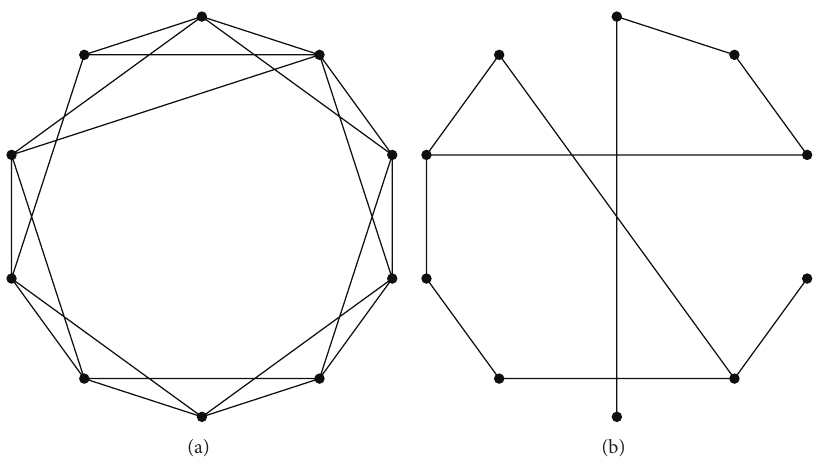
Figure 7: WS Small-Worlds with 10 nodes. In (a) each node connects 4 nodes, and the rewire probability is 0.2; in (b) each node connects 2 nodes, and the rewire probability is 0.4.